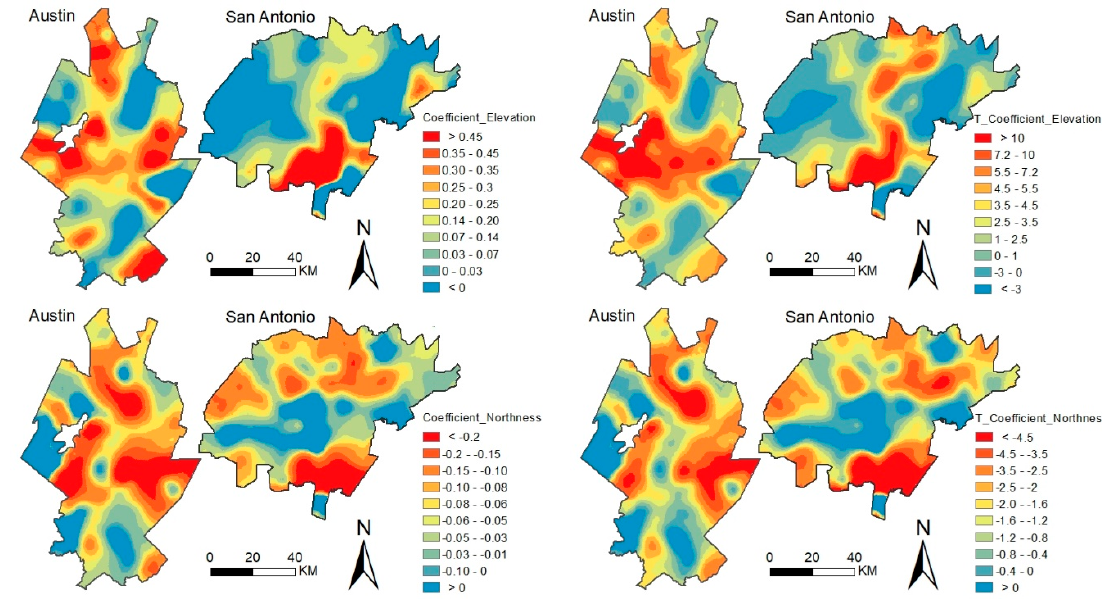
Figure 7. Overall spatial variation of the terrain-related coefficients ( left ) and the t statistics ( right ): elevation and northness.